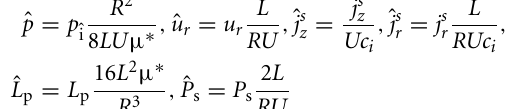
(cid:2) (cid:3) ˆ z and ˆ c out